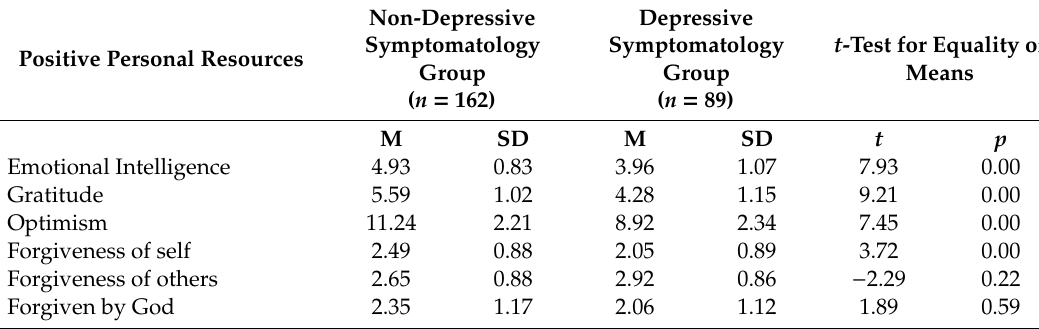
Table 2. Di ff erences in positive personal resources scores between depressive symptomatology and non-depressive symptomatology group: means, standard deviations and t